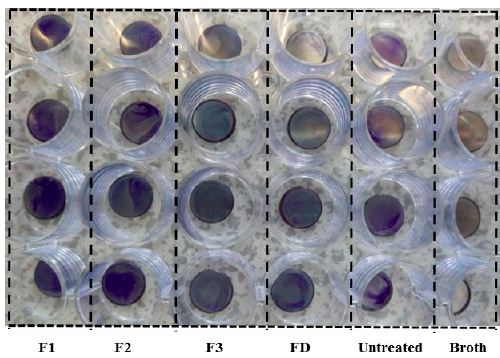
Figure 4. Replicate images ( n = 4) of cyclotide- and DA-modified metal surfaces (F1, F2, F3, and FD) after incubation with S. aureus . Metal disk samples treated with DA, P1, P2, and P3 were denoted as FD, F1, F2, and F3, respectively.